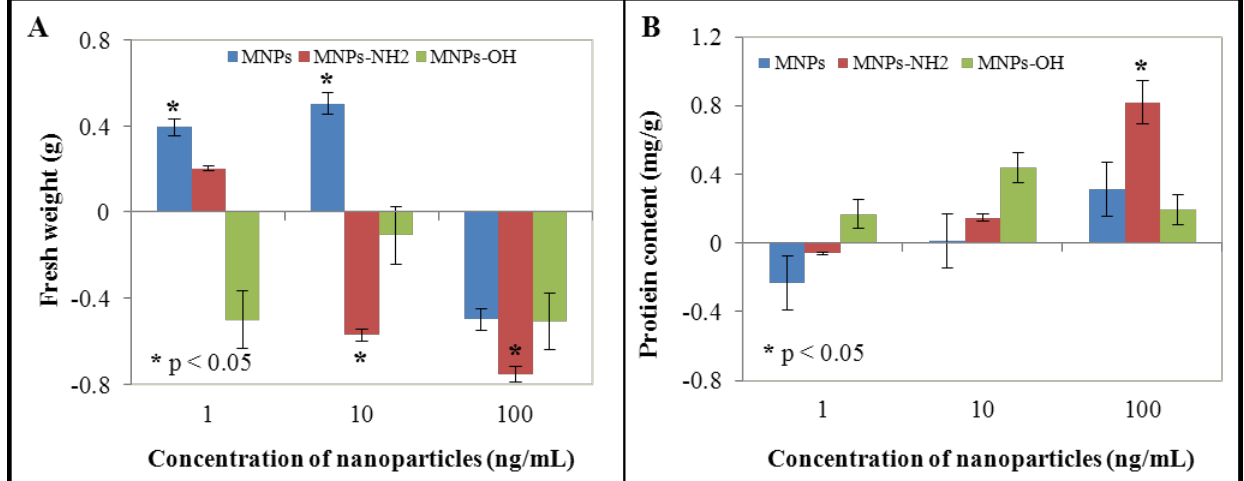
Figure 1. The influence of 0, 1, 10 and 100 ng/mL of magnetic γ-Fe (NPs) and modified magnetic nanoparticles (MNPs—Fe fresh weight and ( B ) protein content of treated tobacco BY-2 cells. The results were subtracted from the control, i.e. , non-treated BY-2 tobacco cells. The cells were treated for five